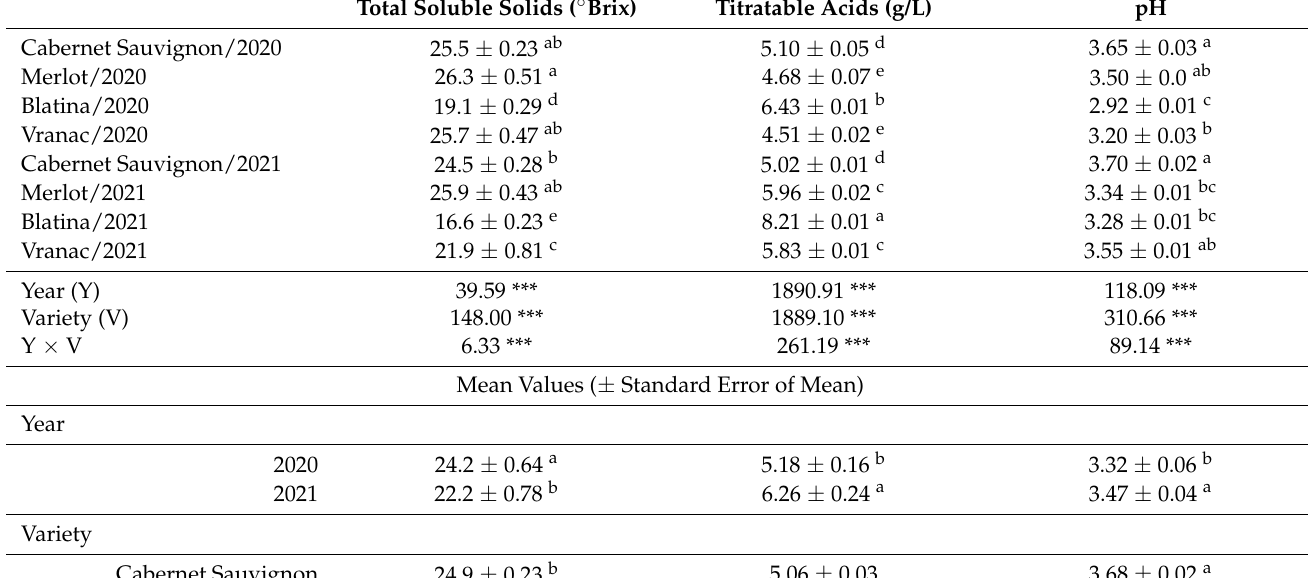
Table 6. Grape quality of the analyzed varieties during the research period at the Mostar locality. Total Soluble Solids ( ◦ Brix) Titratable Acids (g/L)